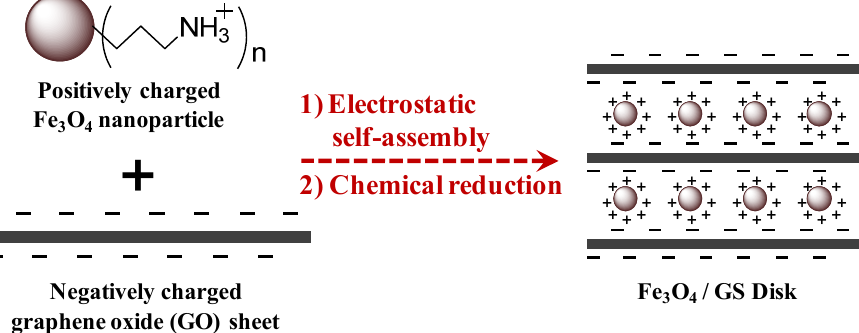
Scheme 1. Schematic diagram for the electrostatic self-assembly process.